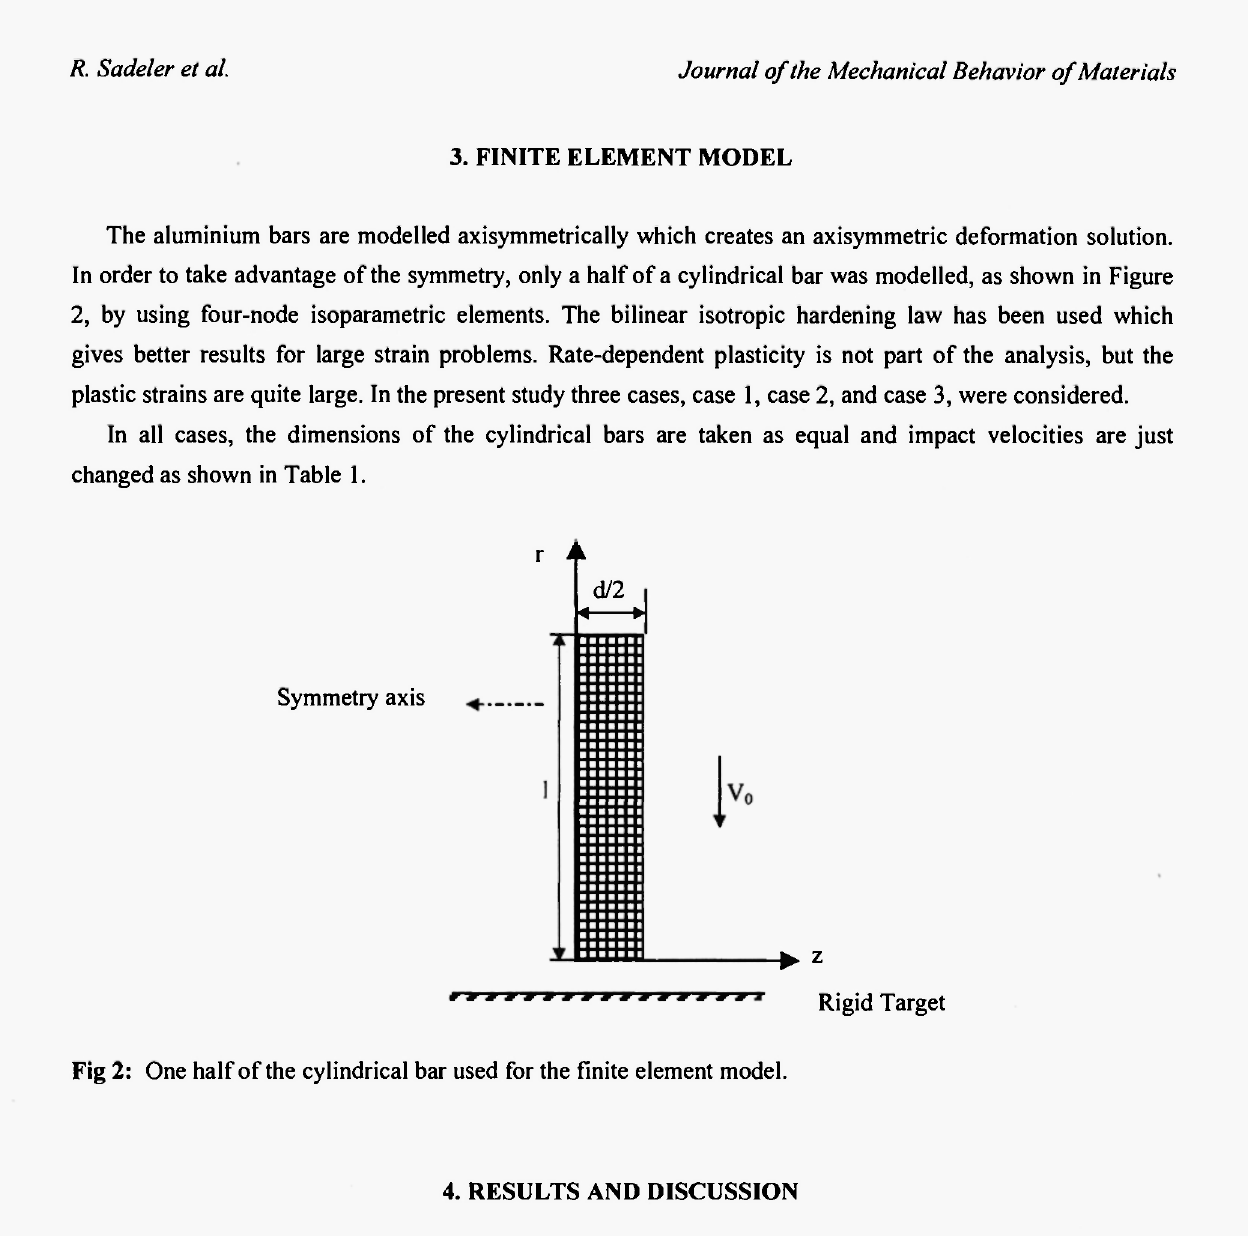
Fig 2: One half of the cylindrical bar used for the finite element